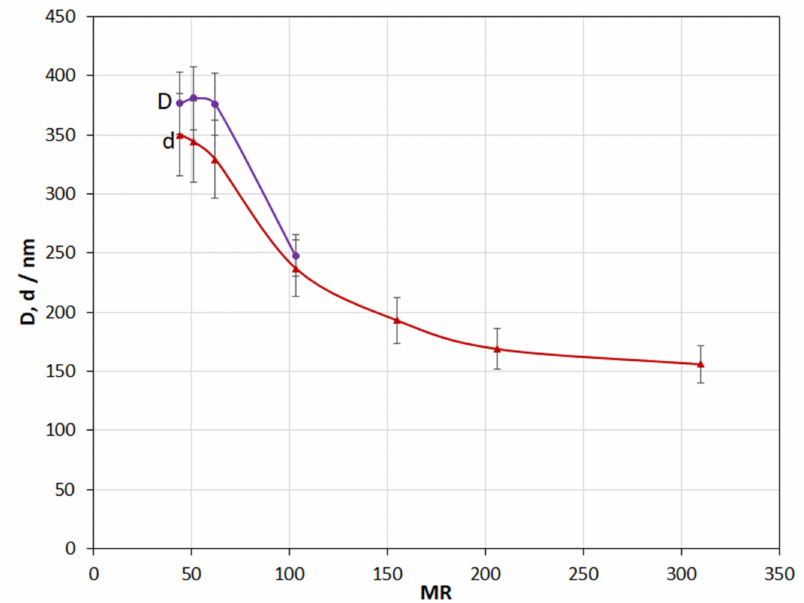
Figure 8. Dependence of the average coating thickness (D) and average particle size (d) on the molar ratio H 2 O/TEOS (MR) in the reaction